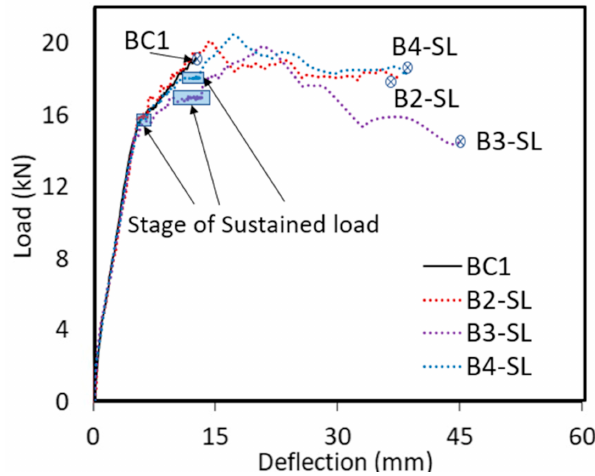
Figure 9. Load vs. deflection response of beam series I.